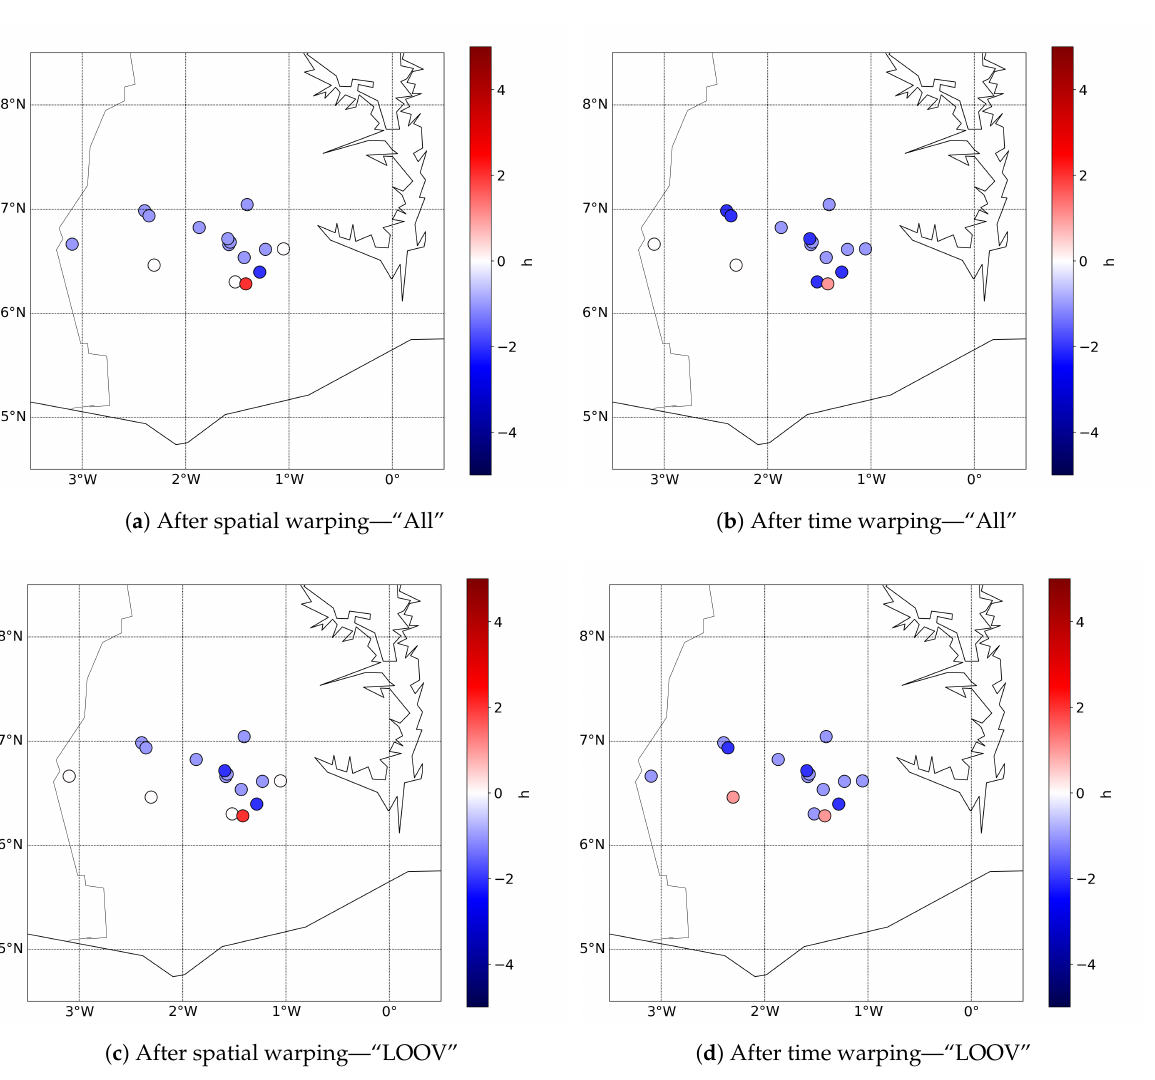
Figure 18. Improvement in timing error after spatial warping (only at stations that recorded >0.1 mm/h). The results are shown for the two experiments, ( top ) “All” and ( bottom ) “LOOV”, and the two methods, ( left ) spatial warping and ( right ) time warping. In blue, the absolute timing error decreased after the warping. In red, the timing error